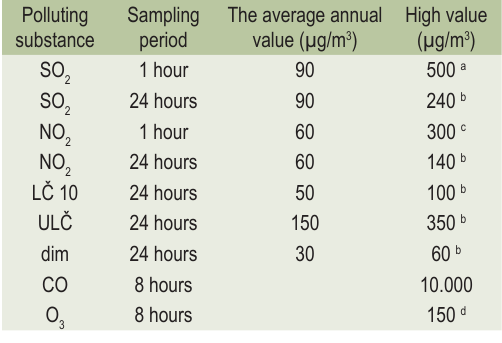
TABLE 1. Limit values (LV) of air quality in order to protect human health